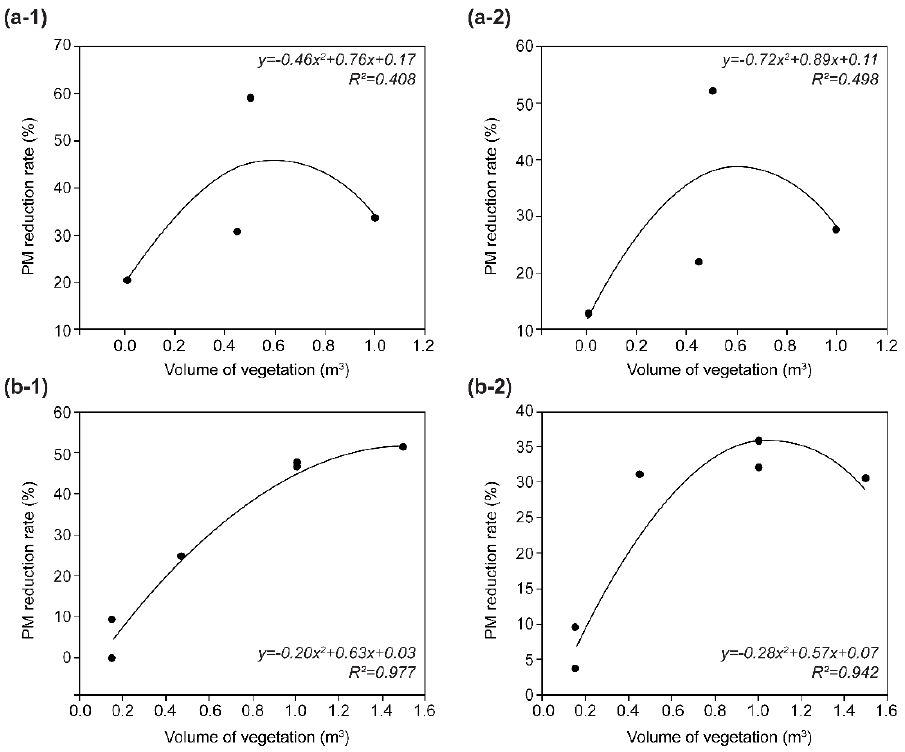
Figure 9. The predictive model of the PM reduction rates for different vegetation volumes at the pedestrian breathing height of 1.5 m: ( a-1 ) PM 2.5 along the four-lane road, ( a-2 ) PM 10 along the four-lane road, ( b-1 ) PM 2.5 along the eight-lane road, and ( b-2 ) PM 10 along the eight-lane road.